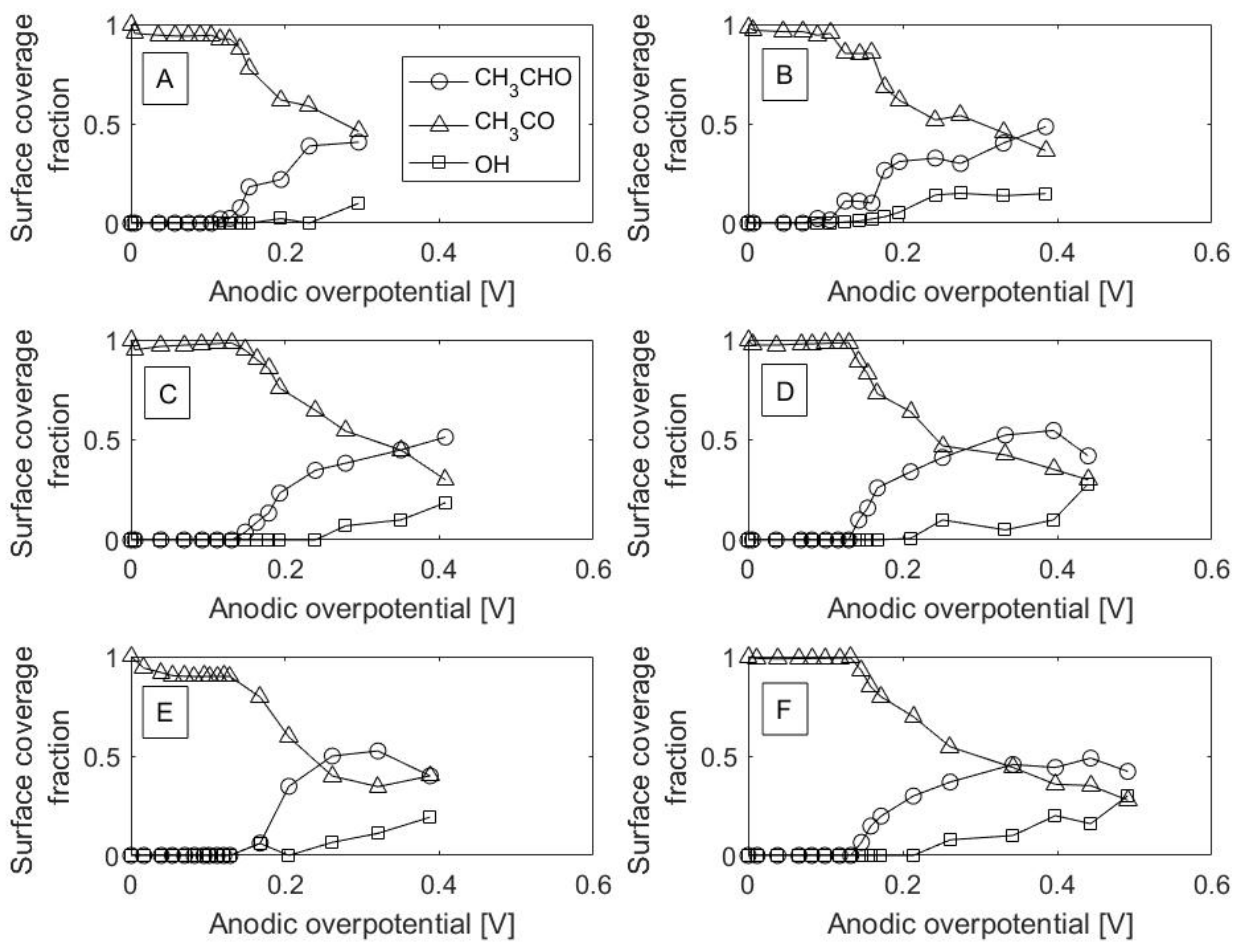
Figure 2. Surface coverage fraction distributions for Pt – Sn catalysts. ( A ) Pt 9 Sn; ( B ) Pt 4 Sn; ( C ) Pt 3